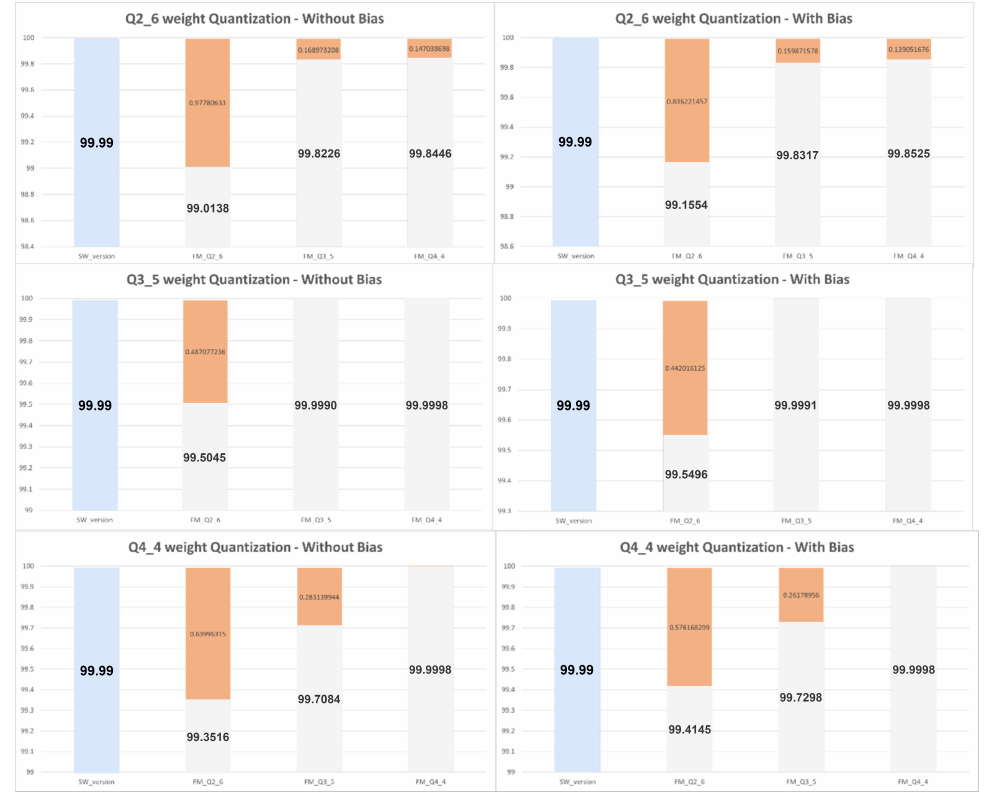
Figure 12. Evaluate classification score for Q2_6/Q3_5/Q4_4 weight quantization and Q2_6, Q3_5, and Q4_4 FM quantization. Blue bar provides SW data, grey quantized data and orange bar provides difference from SW_version and each quantized